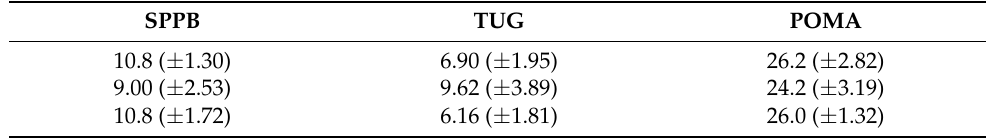
Table 2. The mean post-test measurements T 1 for the three groups 1 .